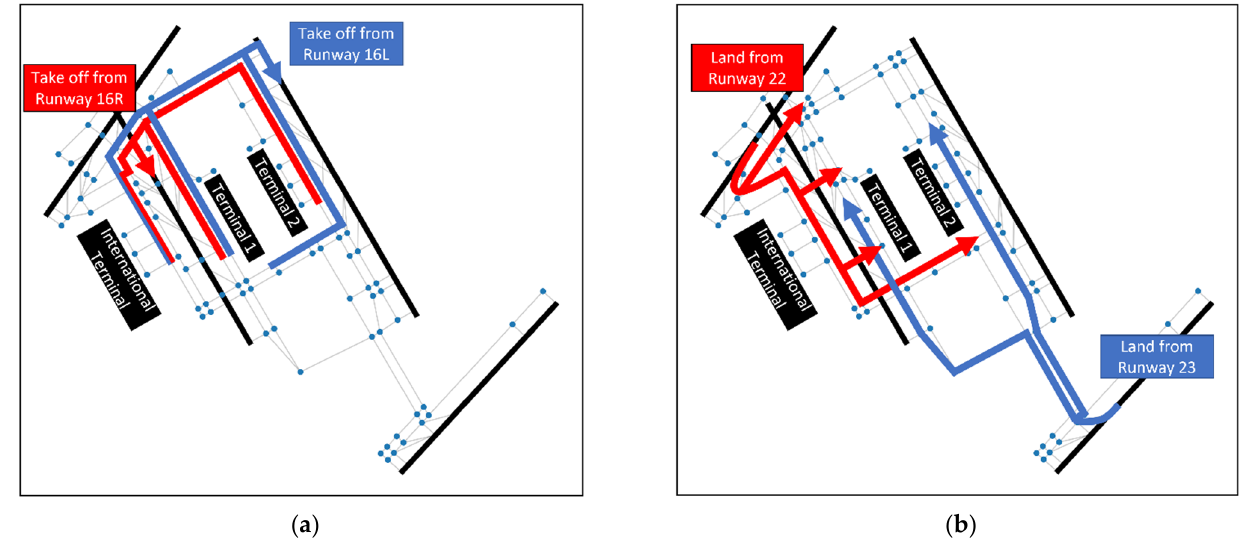
Figure 2. Taxiway selection patterns. ( a ) Take-off. ( b ) Landing. (Source: CARATS Open Data on 9 May 2016).